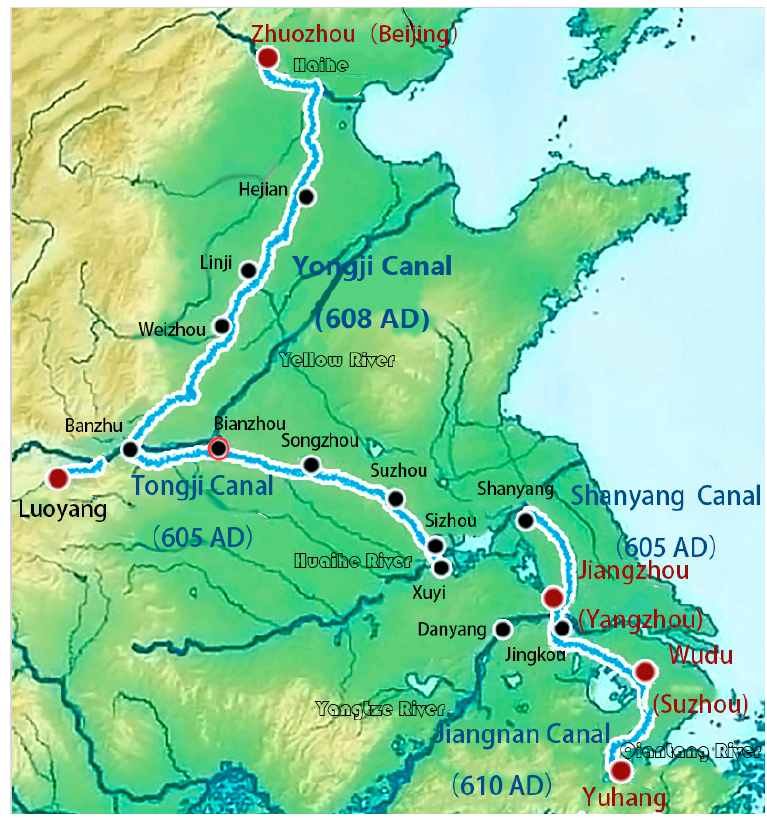
Figure 3. The Grand Canal of the Sui Dynasty went through five river systems in China. Bianzhou (Kaifeng) was located in the main center of the Grand Canal. (Source: https://www.sohu.com/a/237075031_580908, accessed on 2 July 2021).